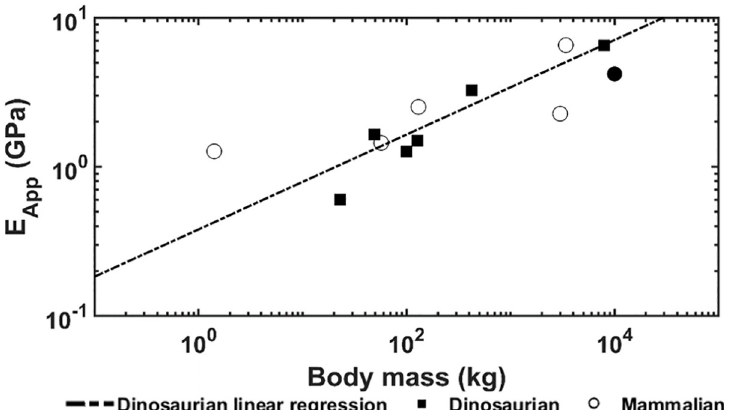
Fig 3. Apparent elastic modulus versus body mass. Trabecular bone apparent modulus is positively correlated with body mass in dinosaurs, while for mammalian species no correlation is observed. The solid circle indicates the mammoth.